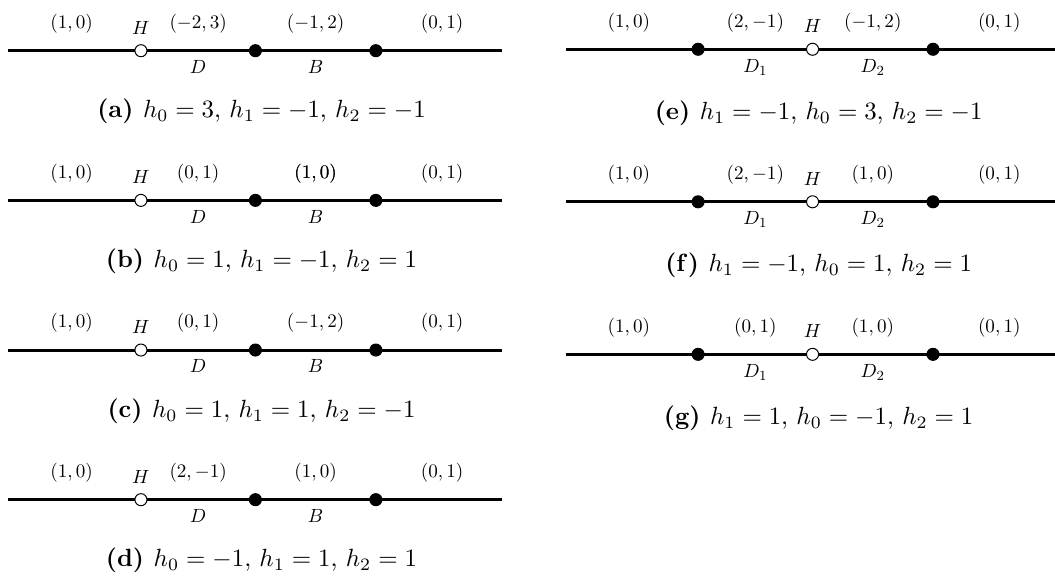
Figure 1. Rod diagrams for all seven 3-centred single black hole solutions. (a){(d) have the horizon at the (cid:12)rst centre (0 < a 1 < a 2 ); (e){(g) have a central horizon ( a 1 < 0 < a 2 ). The numbers above each axis rod specify the biaxial Killing vector that vanishes on the rod with respect to the basis ( v (cid:0) ; v + ) where v (cid:6) = @ (cid:30) (cid:7) @ . ending on the horizon and an S 2 -topology surface B (bubble), respectively. If a ((cid:12)gure 1(e){(g)) the axis rods both correspond to discs D at r = 0. These noncontractible 2-cycles correspond to the (cid:12)xed points of the rotational Killing vector (cid:12)elds along the axis. For each axis rod I corresponding to a 2-cycle C (bubble or disc) one can de(cid:12)ne a magnetic potential via d(cid:8) Killing vector vanishing on I and the integration constants are (cid:12)xed such that (cid:8)